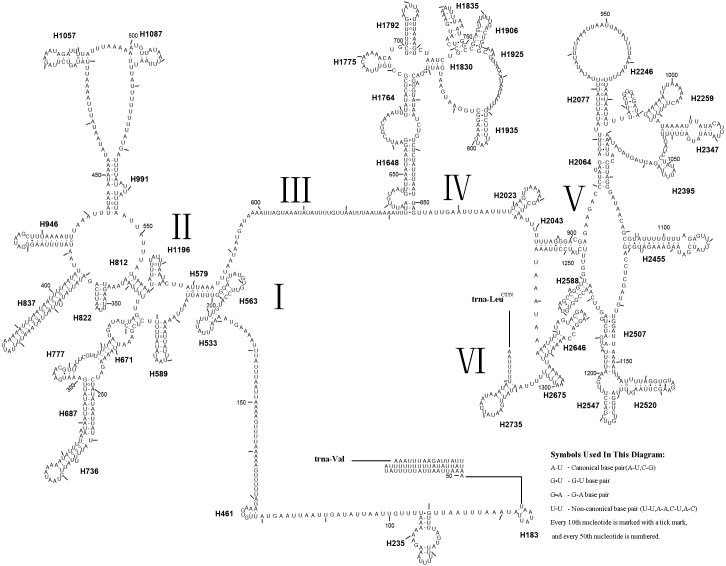
Predicted rrnL secondary structure in the A. xanthosoma mitochondrial genome.The numbering of helices follows Gillespie et al. (2006). Roman numerals refer to domain names.